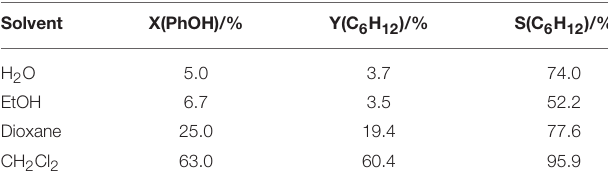
TABLE 5 | HDO of phenol over 1%Pt/SBA-Pr in different